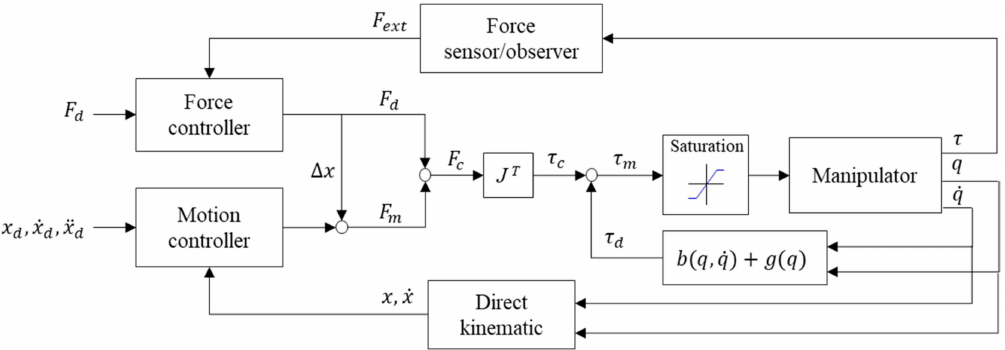
Figure 8. General force control